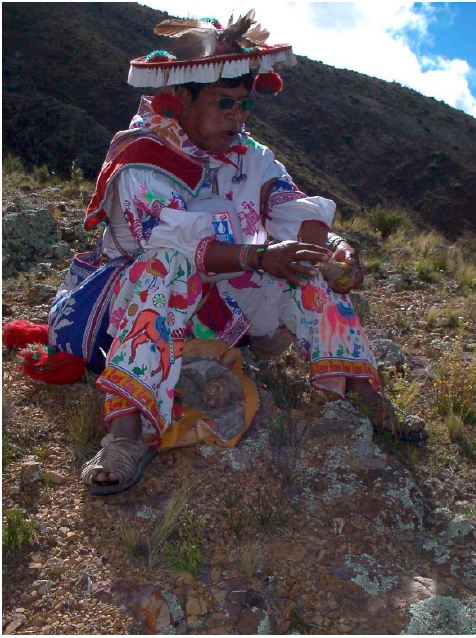
Figure 1. From a journey with Wixarika shaman or marakame Don Marcelino in Wirikuta. His sonic hat and the bright colors he wears stimulate the heightened sensing that is integral to being a marakame and extending healing to participants of the pilgrimage. All figures in this article were created by Marcos Lutyens.